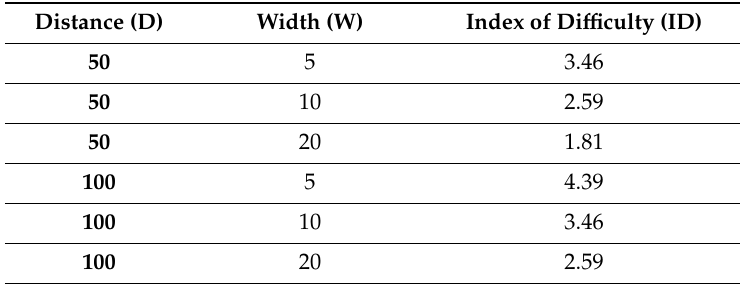
Table 3. Target distance (D) and width (W) from the origin. ID is the index of di ffi culty (in bits) of each target based on D and